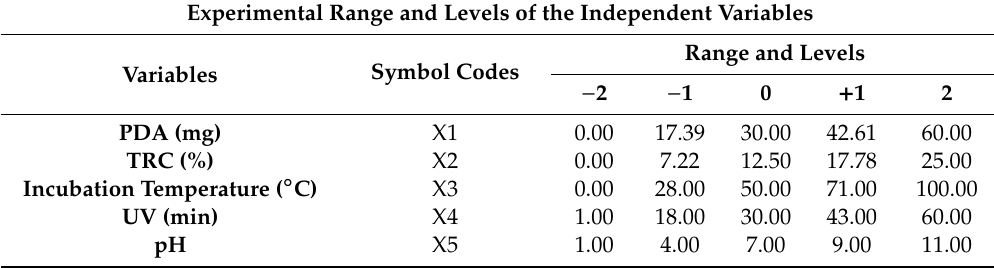
Table 1. Experimental range and levels of the independent